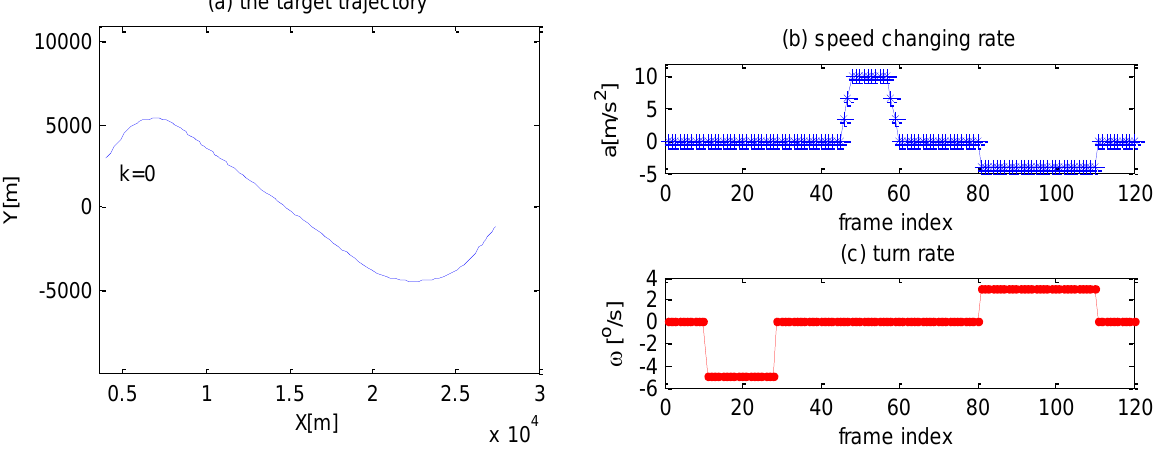
Figure 3. ( a ) Target trajectory ( b ) Speed changing rate of the target ( c ) Turn rate of the